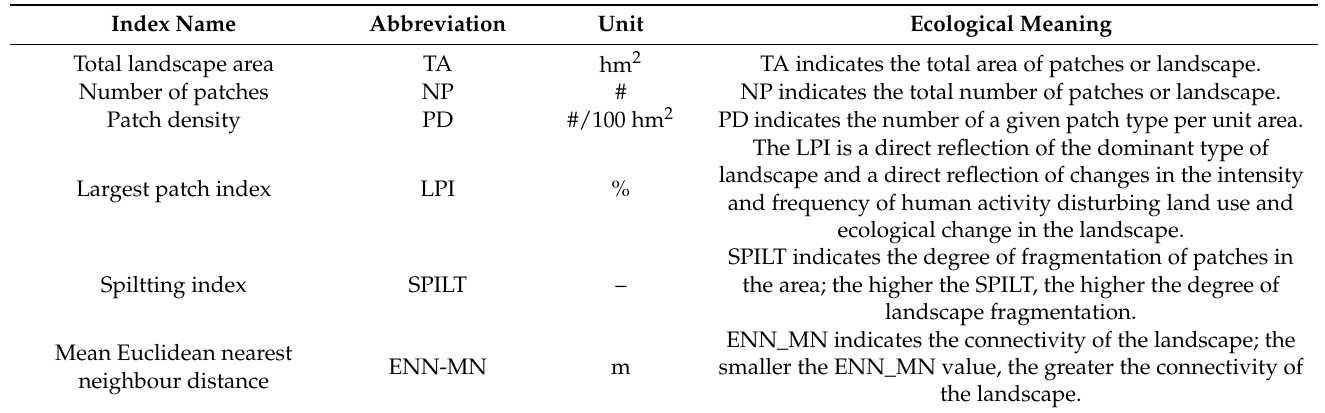
Table 2. List of landscape pattern indices selected of this